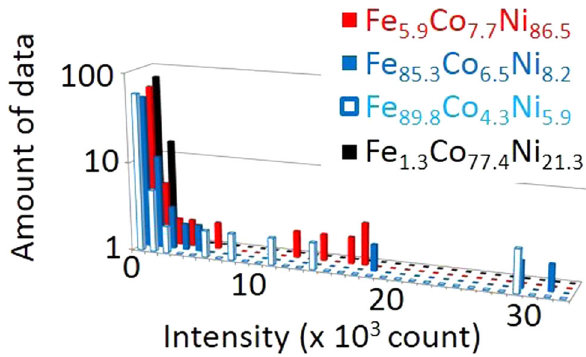
Fig. 3 Data distribution (histogram) with respect to the diffraction intensity for four selected XRD patterns